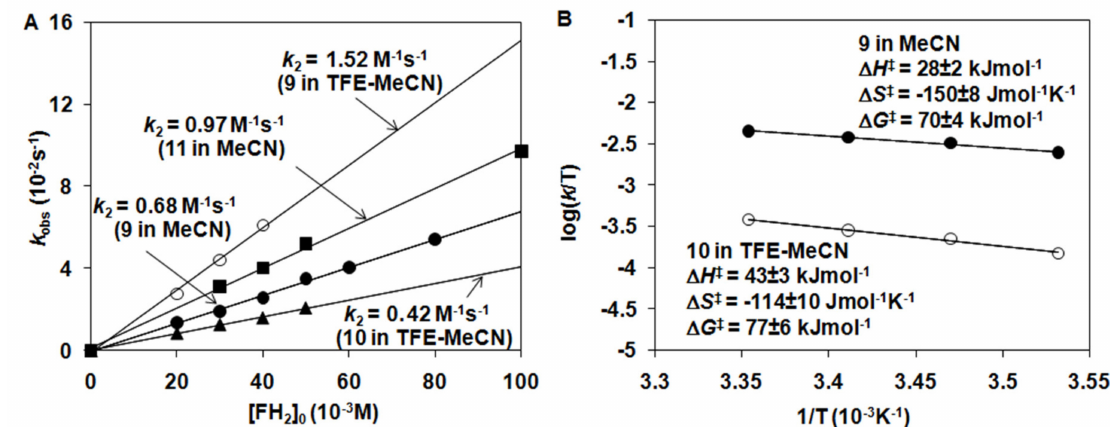
Figure 7. ( A ) Determination and comparison of second-order rate constants by plotting k obs values against flavanone concentration for a series of M IV (O) complexes in CH 3 CN at 10 ◦ C, [M] 0 = 2 mM. ( B ) Eyring plots of log k/T versus 1/T for 9 and 10 , [9,10] = 2 mM, [FH 2 ] = 50 mM.